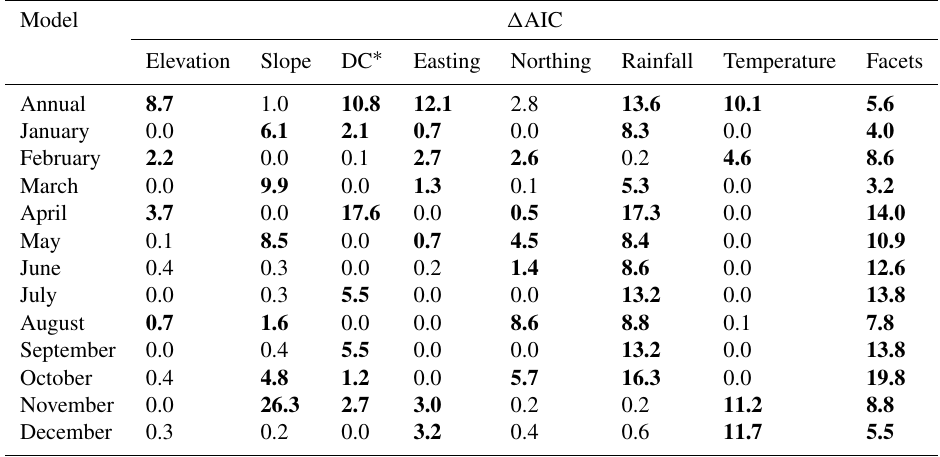
Table 3. Results from the backward stepwise procedure used to select covariates to include in final GAMs for annual and monthly R factor maps computation. The values ( (cid:49) AIC) correspond to the difference in AIC scores obtained when the particular covariate is dropped from the “full” model, i.e. the model containing all the covariates. Scores in bold indicate which covariates were selected in the final